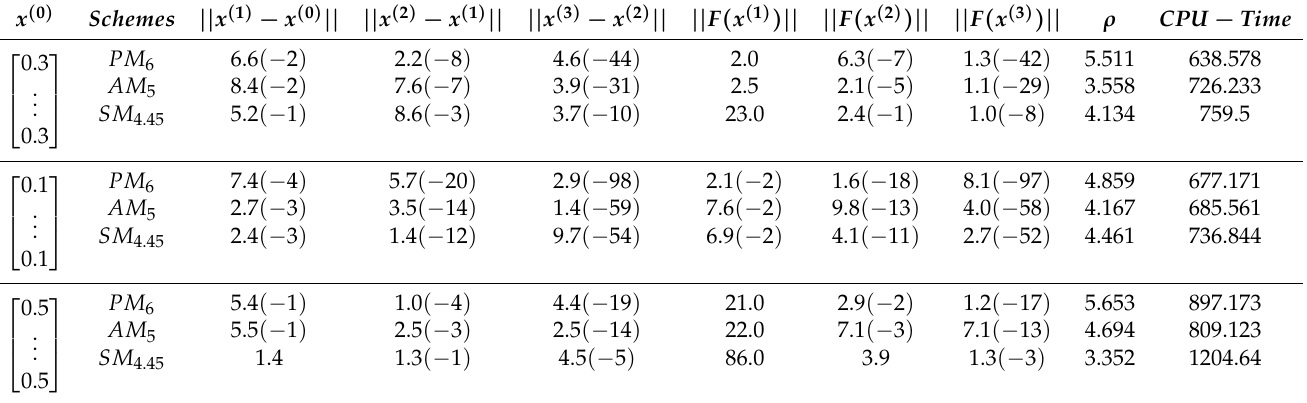
Table 3. Convergence behavior of schemes for Example 3.